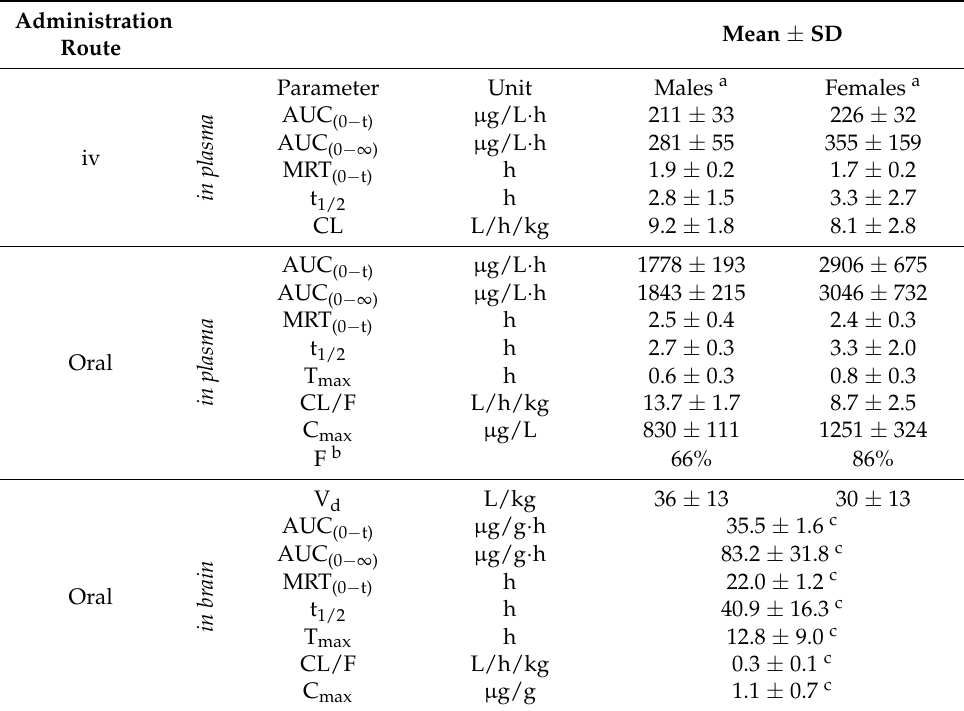
Table 2. Pharmacokinetic parameters of TDMQ20 in rat plasma and brain after oral (25 mg/kg) or intravenous administration (2.5 mg/kg). Calculated by DAS 2.0 software.